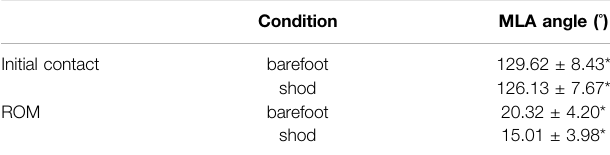
TABLE 2 | Comparison of MLA angle at initial contact and ROM of MLA angle in shod and barefoot conditions.